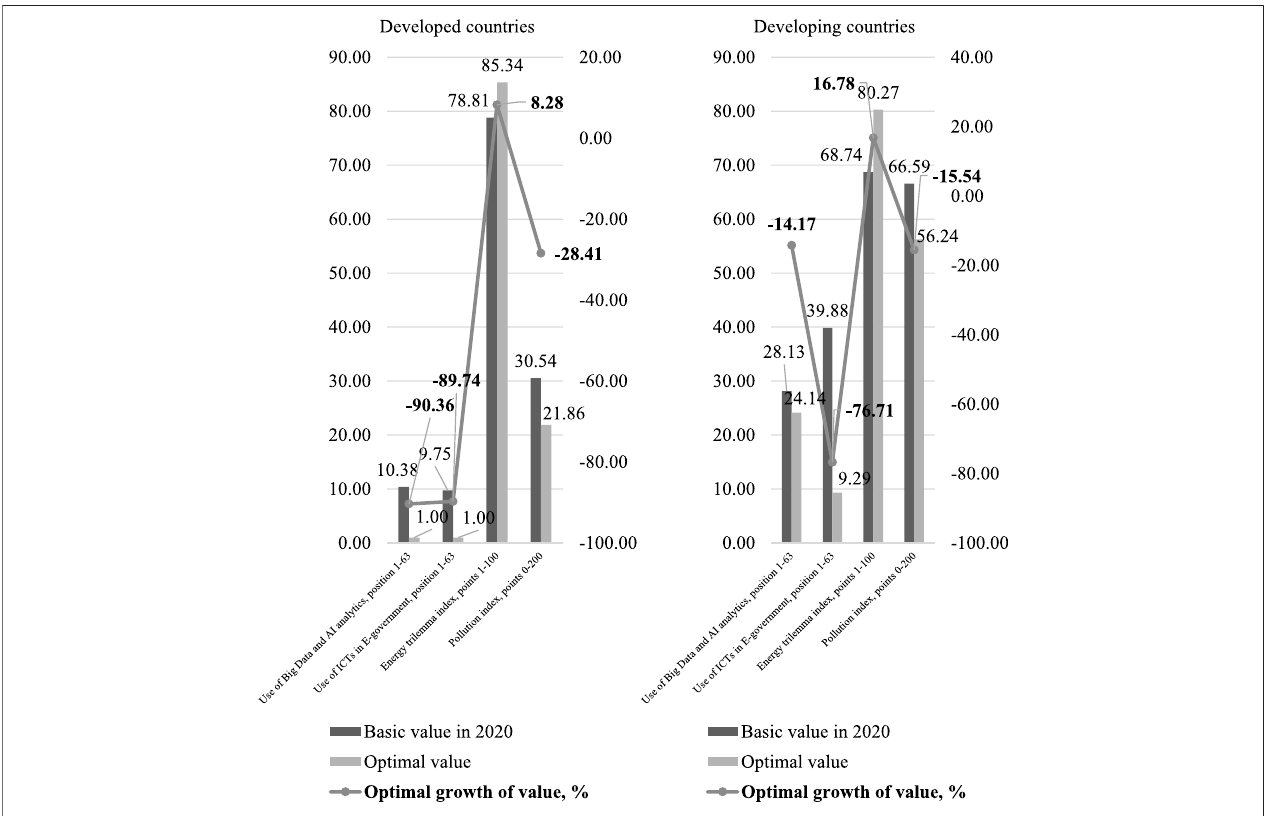
FIGURE 2 | The optimal in fl uence of the ICT factors to increase energy ef fi ciency and environmental pollution control in the period until 2030.